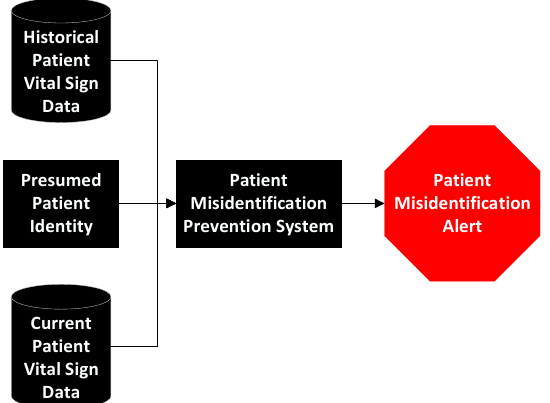
Figure 2. Patient misidentification prevention system diagram.